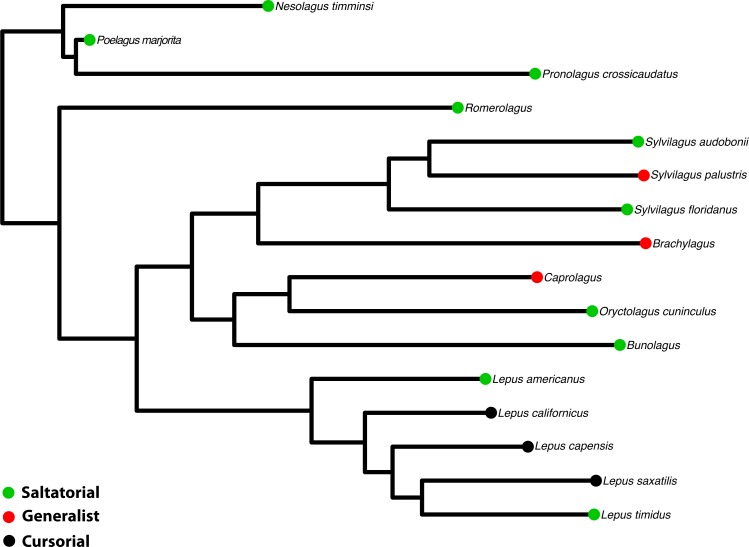
Phylogeny of Leporidae.The phylogenetic hypothesis of the 16 taxa used in this study, pruned from the supermatrix maximum likelihood phylogeny in Matthee et al. (2004). Locomotor styles from Table 1.